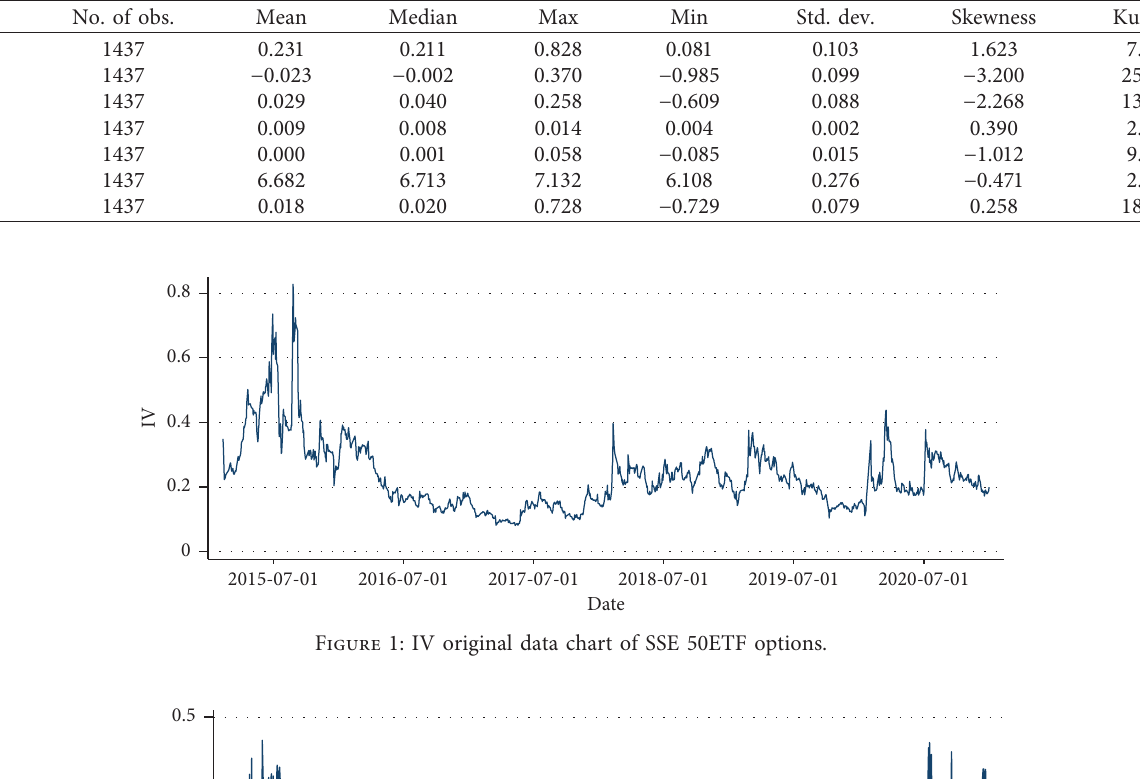
Table 1: Descriptive statistics of variables.